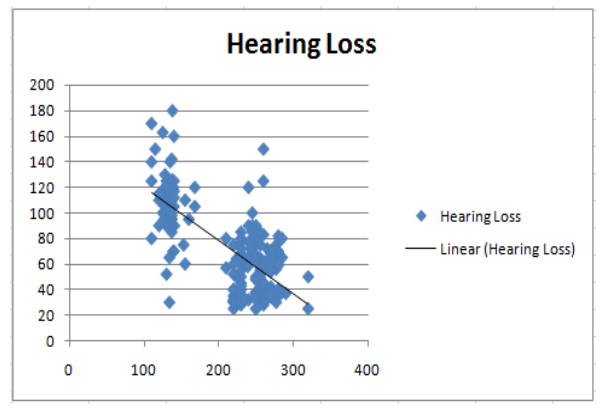
Figure 10. Correlation between hearing loss and diabetic patients